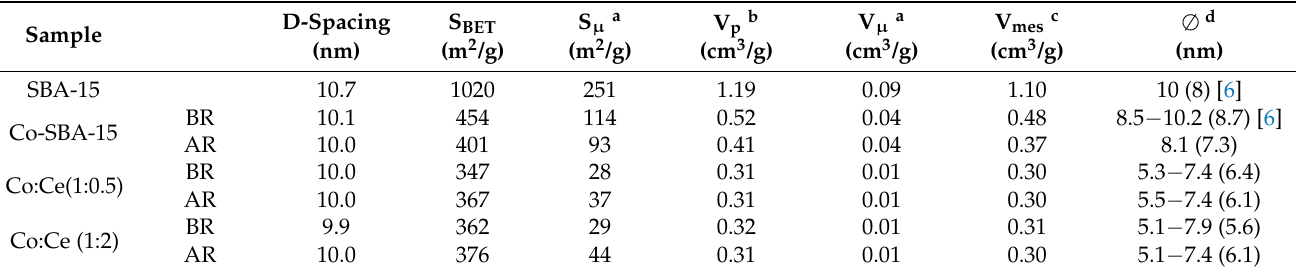
Table 1. D-spacing values, specific surface area (S BET ), micropore surface area (S µ ), total pore volume (V p ), micropore vol- ume V µ , mesopore volume V mes , and pore diameter ( ∅ ) of the catalysts before (BR) and after (AR) reaction ( n -hexane oxidation). Sample